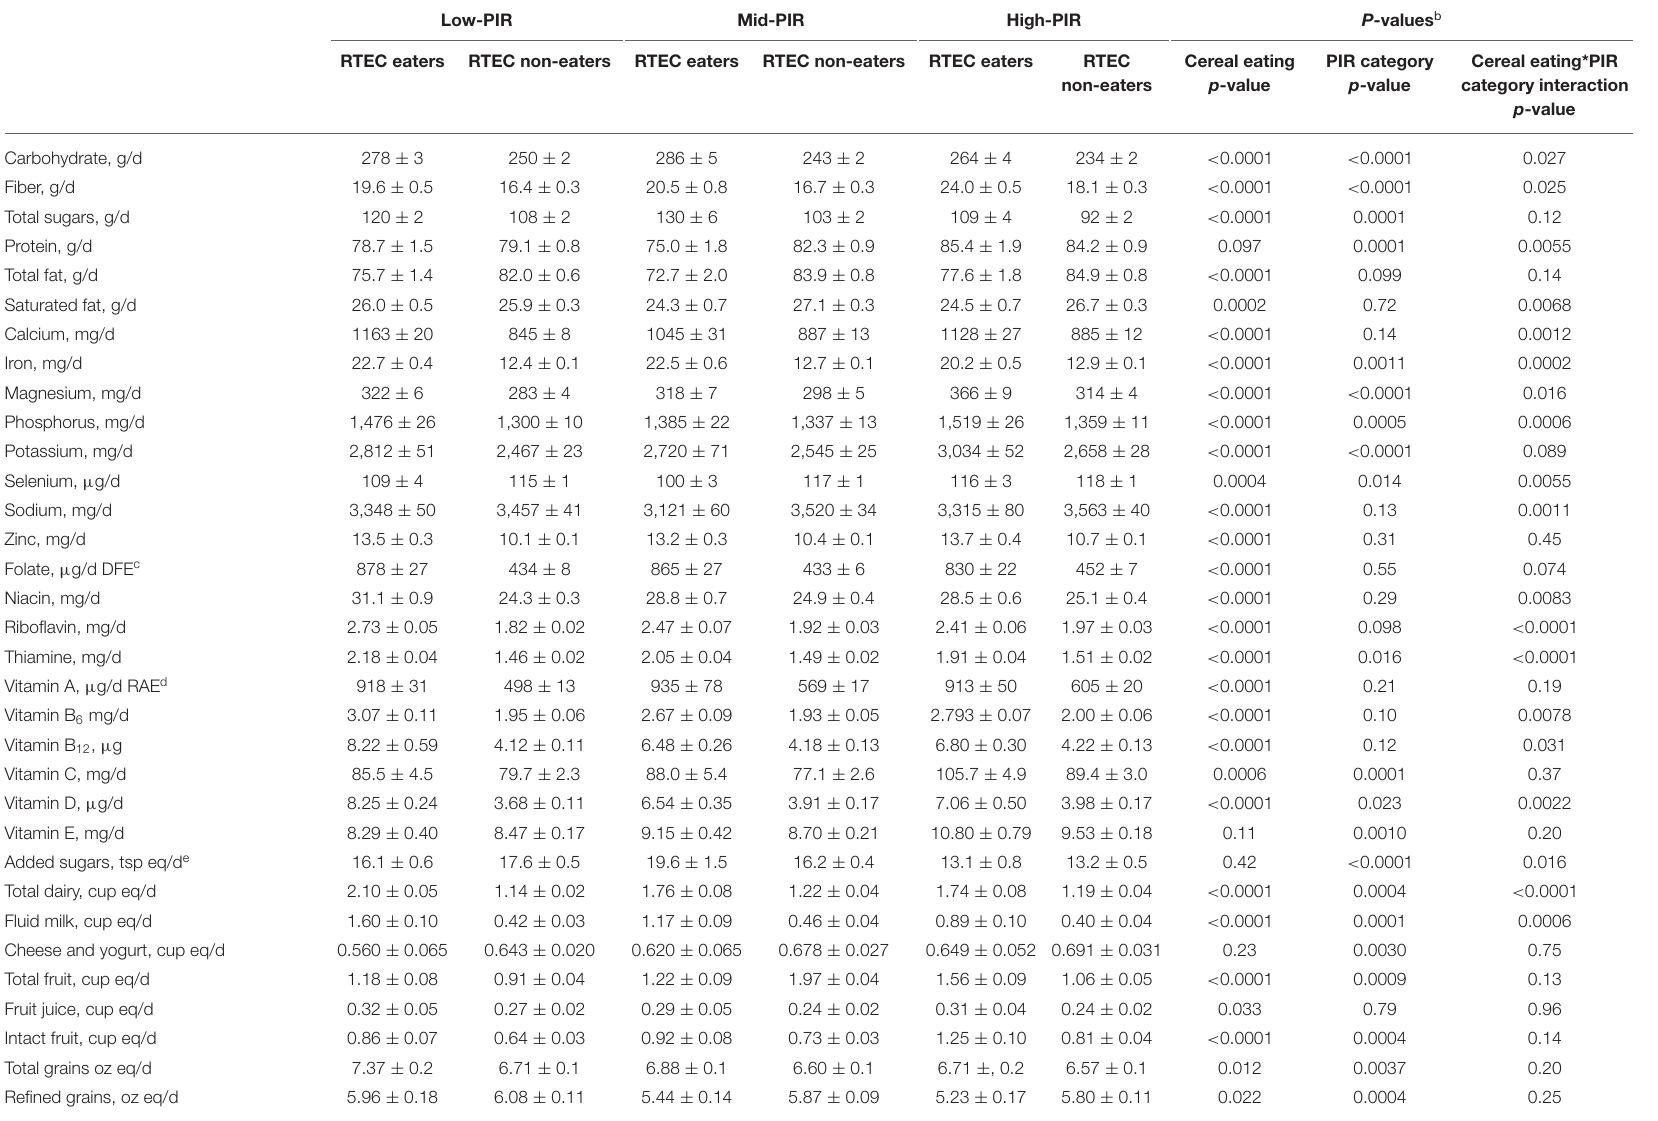
TABLE 3 | Adjusted mean daily nutrient and food group intakes and diet quality for American adults by ready-to-eat cereal consumption and poverty-to-income ratio status, National Health and Nutrition Examination Survey, 2015–2018 a